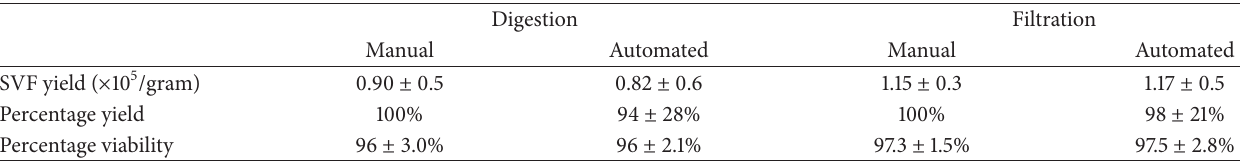
Table 5: Composition of SVF isolated by the automated process as compared to manual isolation.